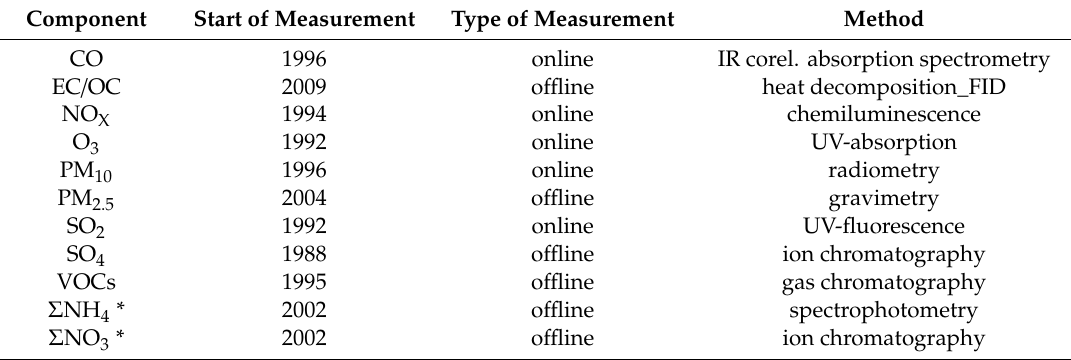
Table 1. Used sampling methods—year of start, type of measurement, method of determination. Component Start of Measurement Type of